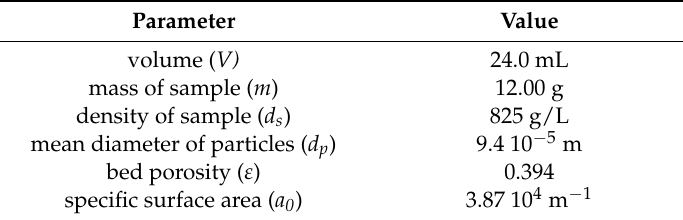
Table 2. The features of the fixed bed using during the